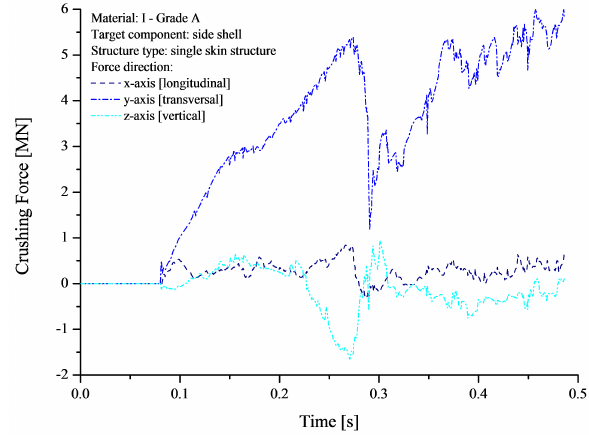
Figure 4: Verification of energy characteristic by the crushing force: single skin structure.